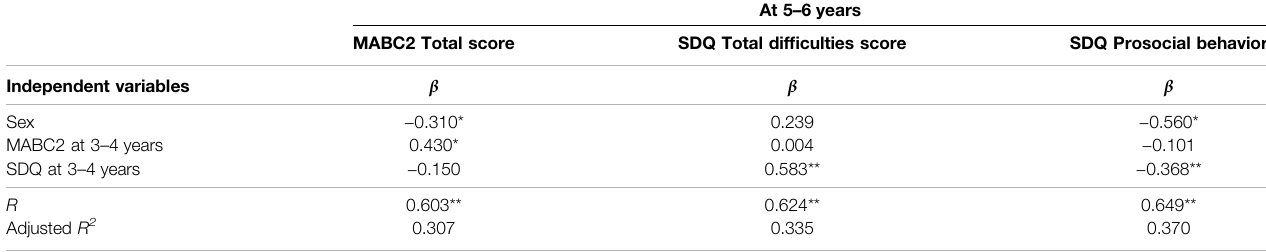
TABLE 3 | Multiple regression analyses